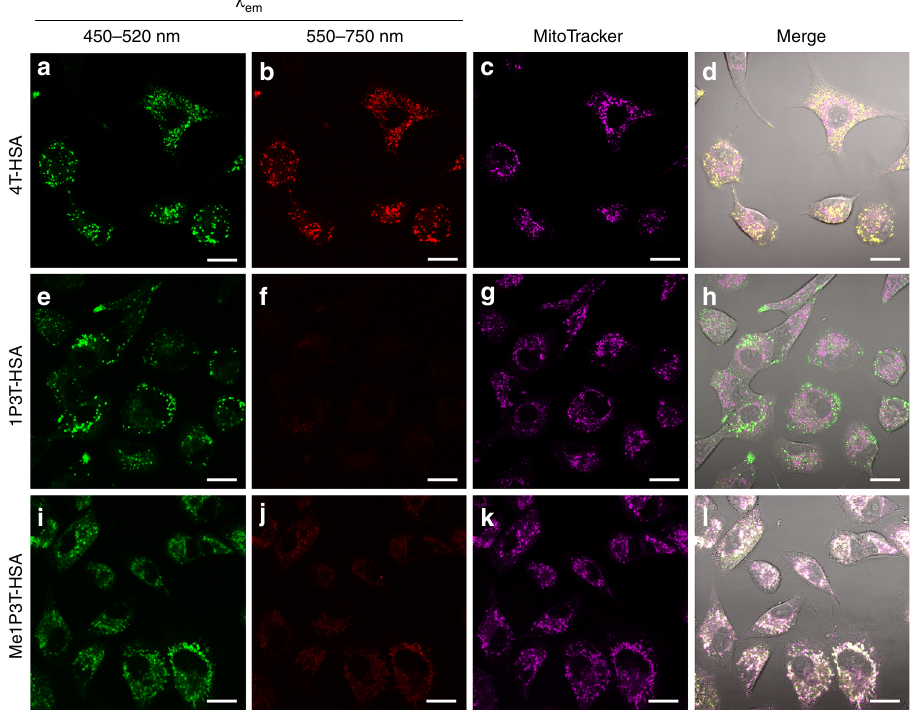
Fig. 8 Inhibition of intracellular vesicle fusion and transport by ba fi lomycin A1. A549 cells were treated with ba fi lomycin A1 (100 nM, 30 min) prior to the introduction of 4T-HSA a – d , 1P3T-HSA e – h , and Me1P3T-HSA i – l at 15 µ M. Images were taken after 24 h incubation at 37 °C, 5% CO 2 with the respective complex. Mitochondria of the cells were stained with MitoTracker Deep Red represented in purple color. The corresponding experiments without ba fi lomycin A1 are presented in Fig. 6. Scale bar = 20 µ m. Ba fi lomycin A1 pretreatment of cells trapped 1P3T e and Me1P3T i in their molecular states (green) within their respective compartments whereas it has no effect upon 4T a assembly (green and red indicating co-existence of molecular and assembled forms). l Co-localization studies suggest that only Me1P3T targets the mitochondria and localizes there in its molecular form (white color of the co-localization of molecular Me1P3T in green and MitoTracker in